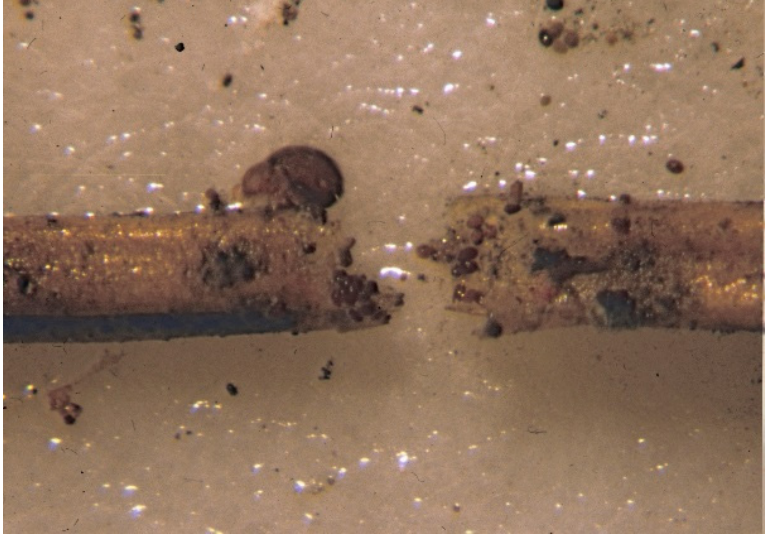
Figure 15. The mite species Steganacarus cf. striculus is seen walking on a fragmented needle. Its faecal pellets are easily seen where the needle is broken.